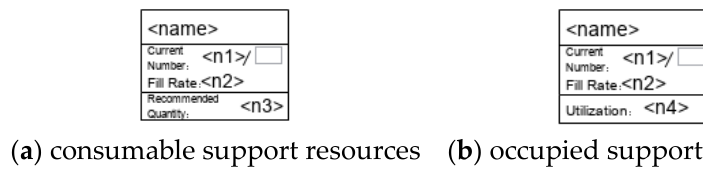
Figure 8. The icon for support resource agent.